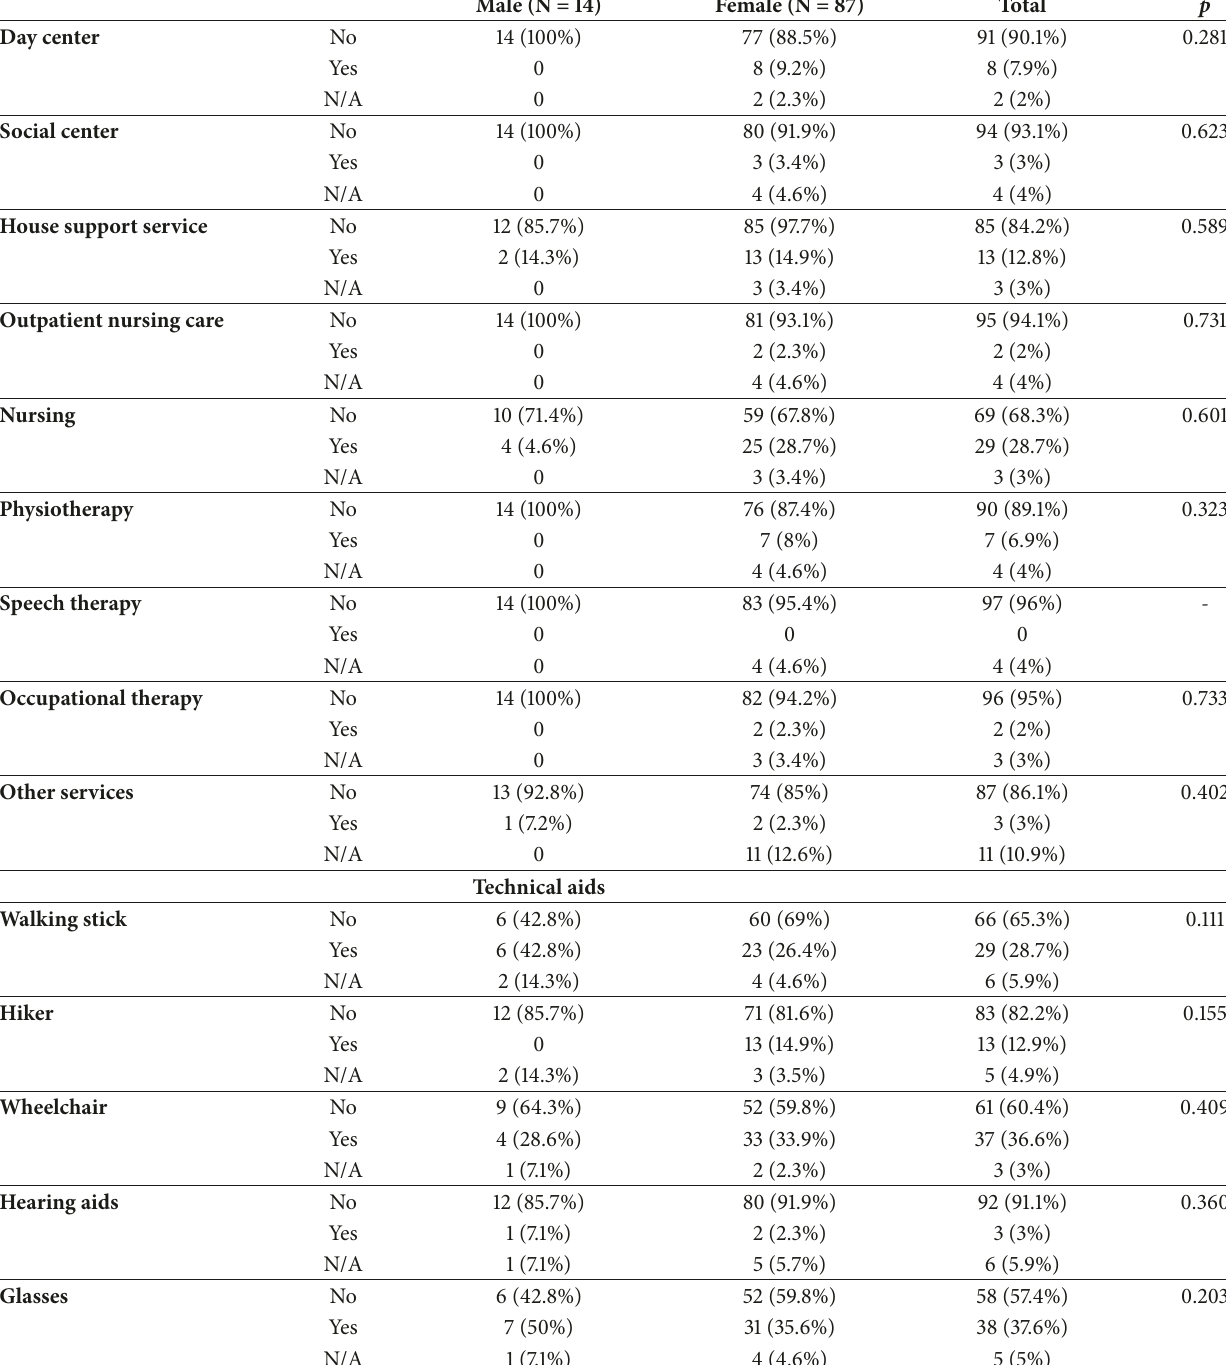
Table 6: Use of elder support services and technical aids by the Portuguese centenarians from Beira Interior ( 𝑁 =